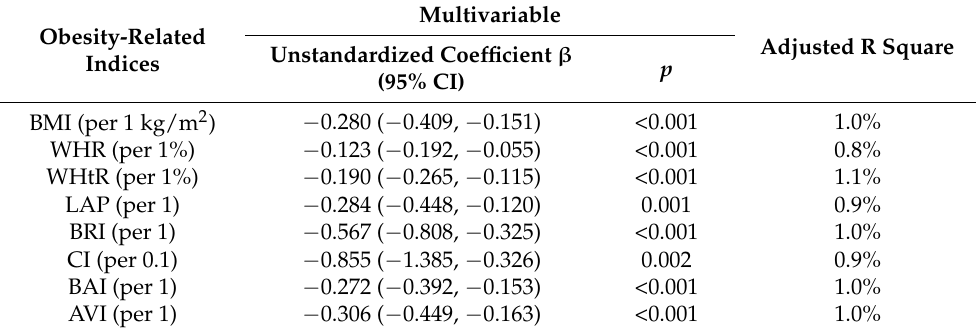
Table 5. Association of obesity-related indices with ∆ FEV1/FVC using multivariable linear regression